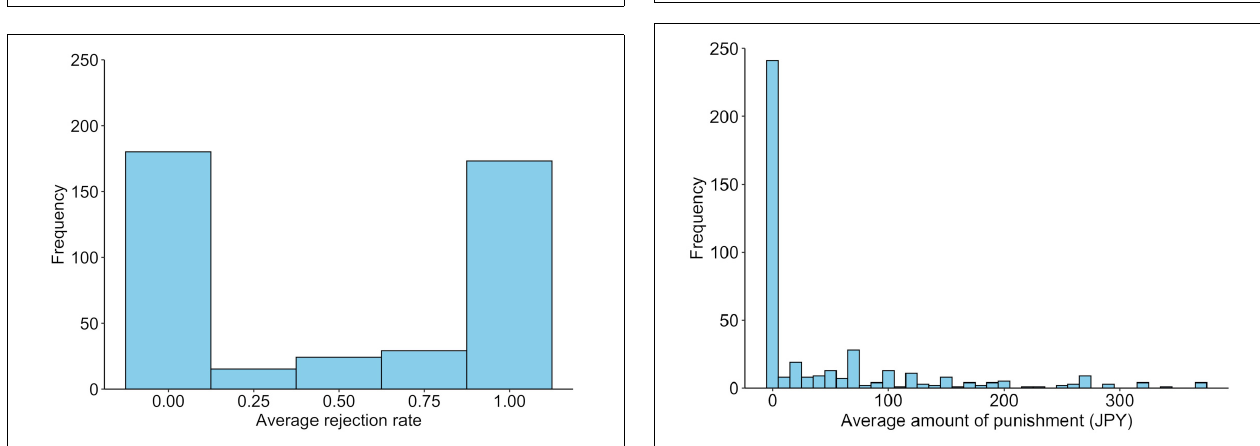
FIGURE 1 | Behavioral response to unfair offers in the ultimatum game among each genotype. Average rejection rate of unfair proposals (30% and less than 30% to responders) in the ultimatum game. Error bars indicate the standard error.